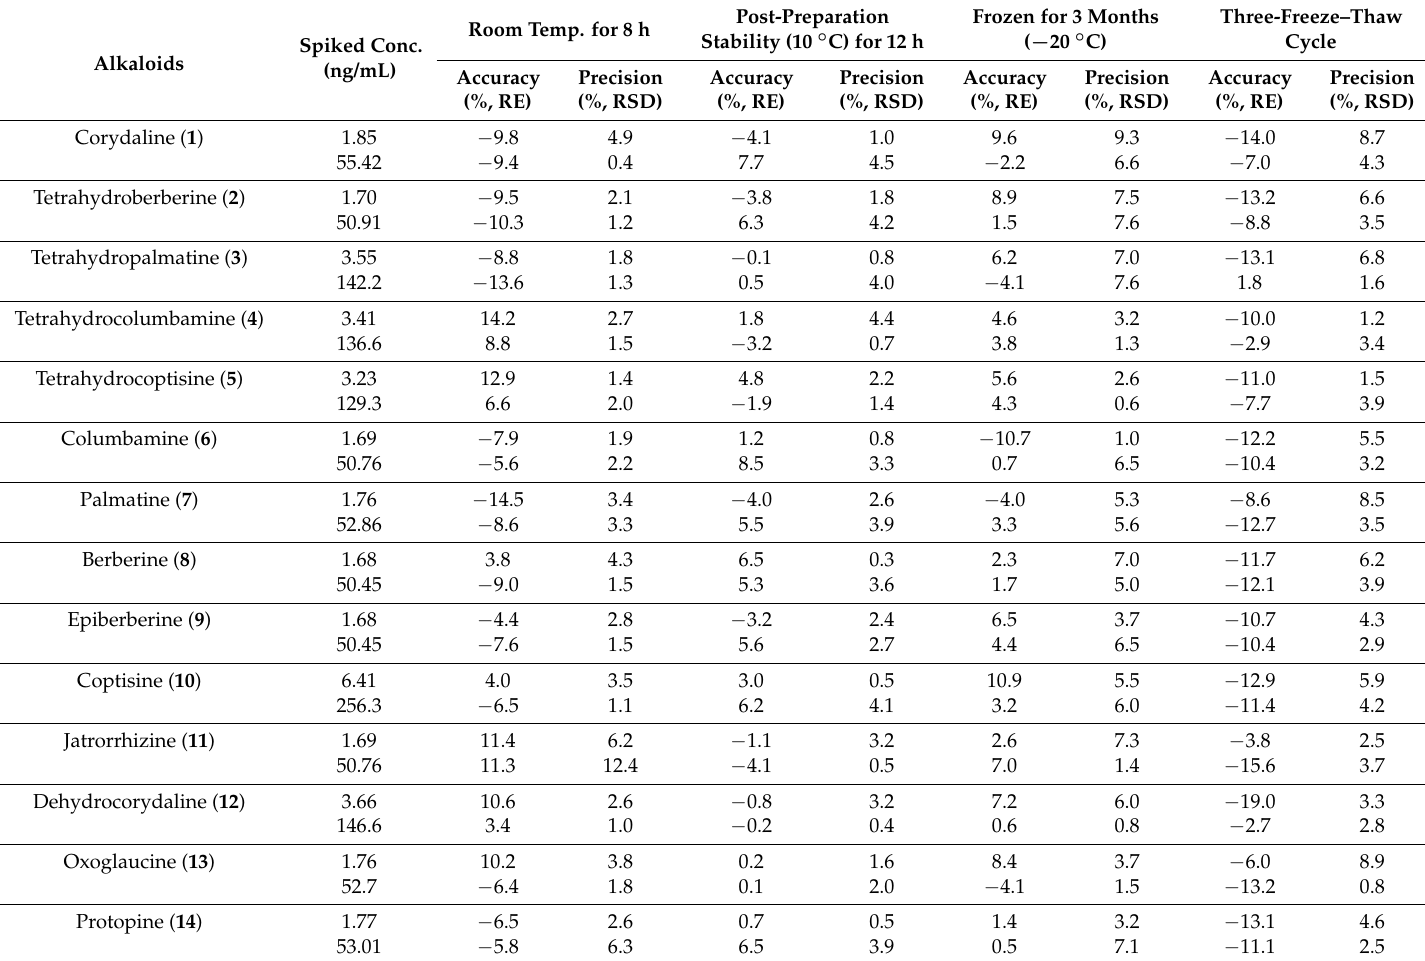
Table 5. The stability of the fourteen alkaloids in ICR mice plasma under different storage